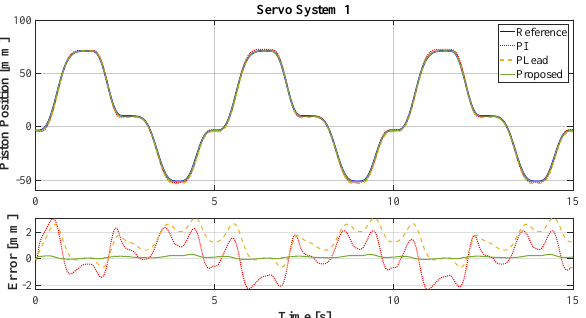
Figure 3: Simulated response for servo system 1, where the linear controllers are extended with a ve- locity feedforward.